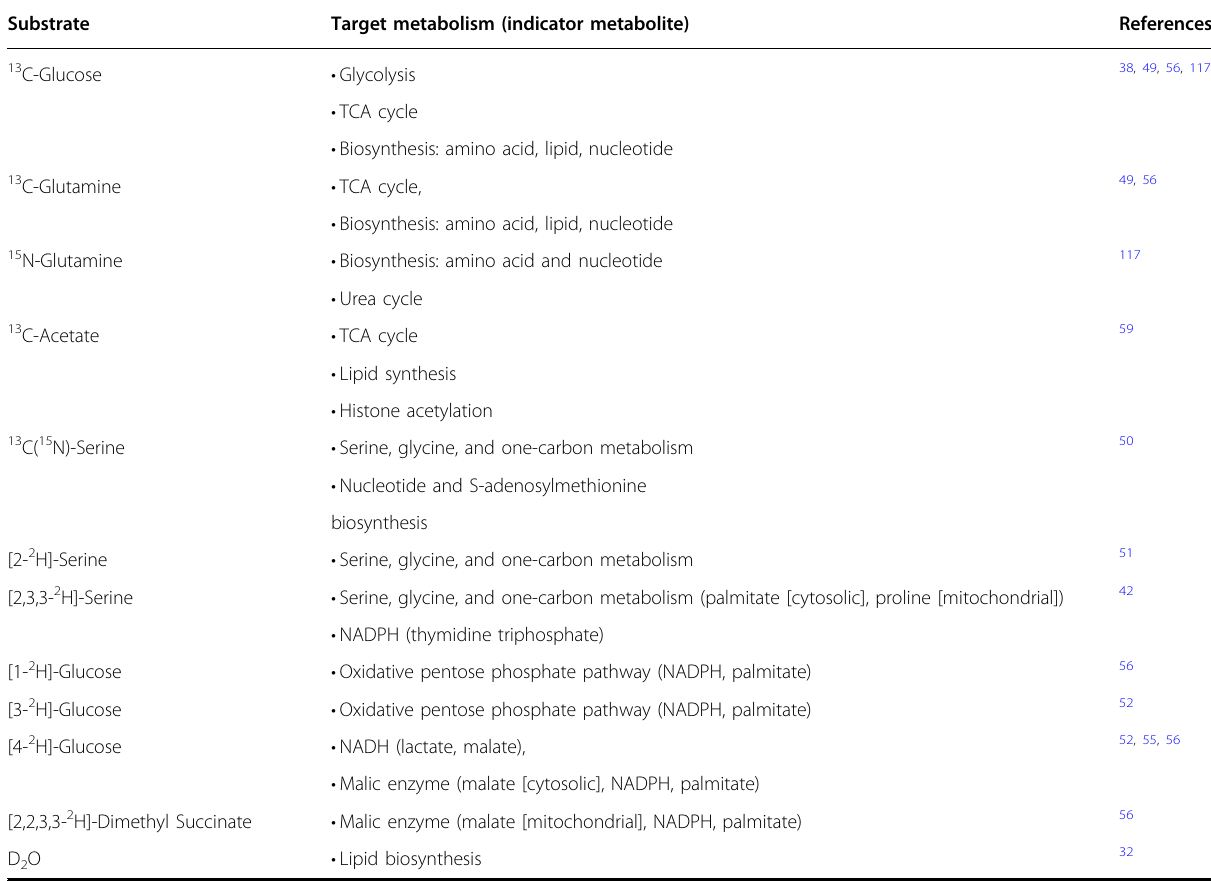
Table 1 Stable isotope-labeled metabolic tracers Substrate Target metabolism (indicator